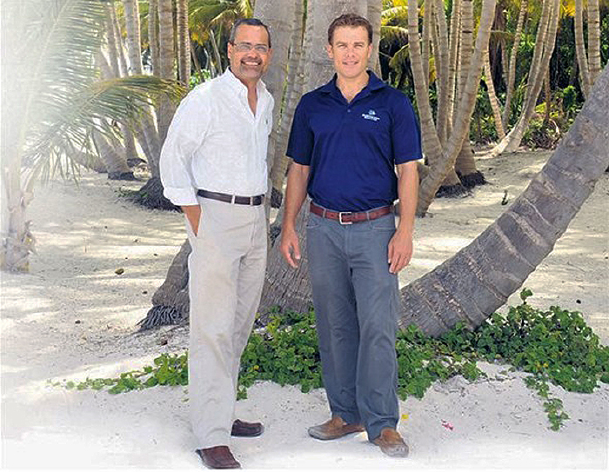
Fig. 8 . Jake Kheel (right), Director of the